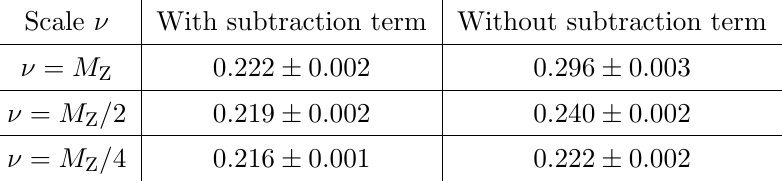
Table 1 . Total cross section for pp of the scale (cid:23) . The statistical error is